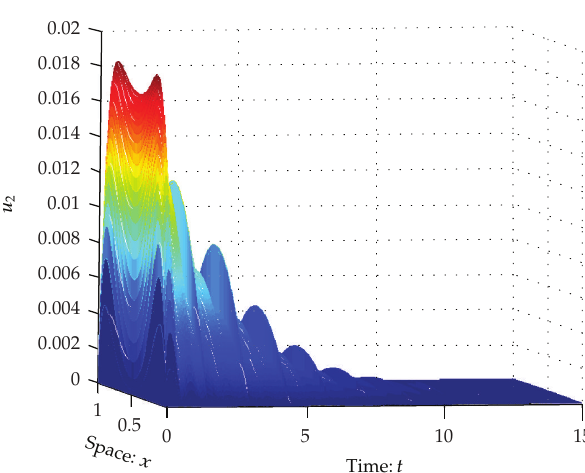
Figure 3: Computer simulation of the state u 2 (cid:3) t,x (cid:4) .